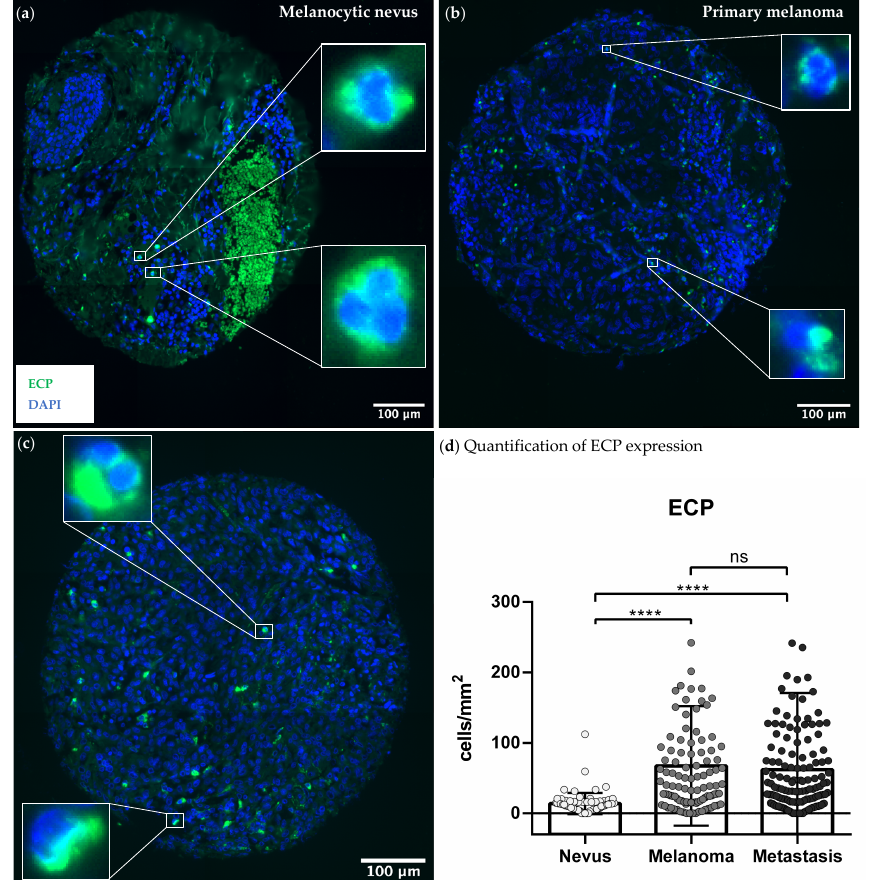
Metastasis Figure 1. Representative expression patterns of ECP+ eosinophils in human tumor tissue sections. Paraffin-embedded tissue samples of 73 melanocytic nevi, 105 primaries and 151 metastases from 118 melanoma patients were stained with immunofluorescent anti-ECP antibodies (marked green). Nuclei were stained in blue with DAPI. ( a ) Exemplary image of a melanocytic nevi stained with anti-ECP antibodies; ( b ) Exemplary image of a primary melanoma stained with anti-ECP antibodies; ( c ) Exemplary image of an associated metastasis of melanoma stained with anti-ECP antibodies; ( d ) Comparison of ECP expression between nevi, primaries and metastases of melanoma patients. Abbreviations: ECP: eosinophil cationic protein; DAPI = 4 (cid:48) ,6-Diamidin-2-phenylindol; ns: not significant; ****: p <